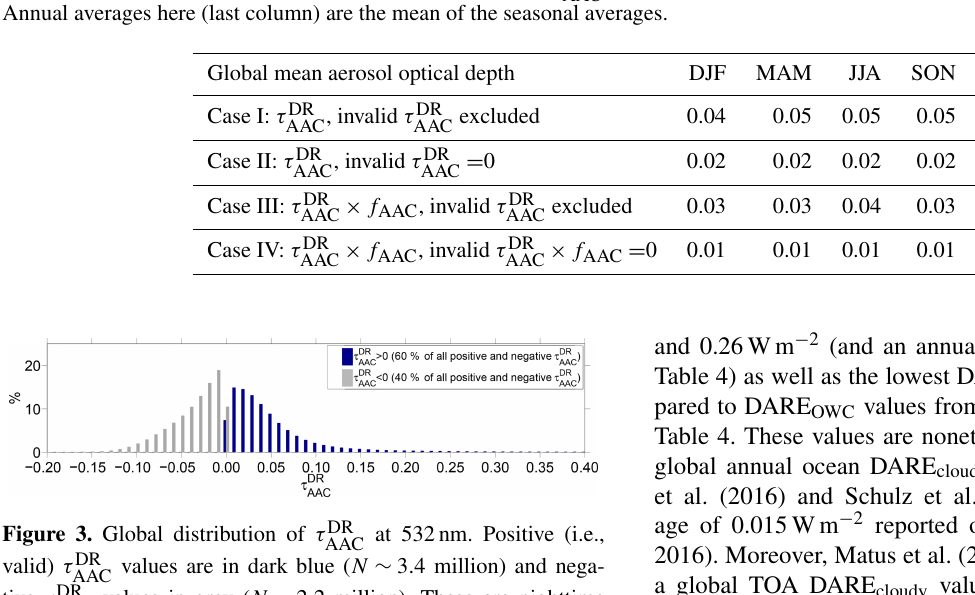
values. White pixels AAC DR × f < 0 (Case I and II) or τ DR AAC (Case III and IV) when assuming either (i) τ AAC AAC AAC < 0 cases are set to zero and included in the averages (Case II and IV). AAC